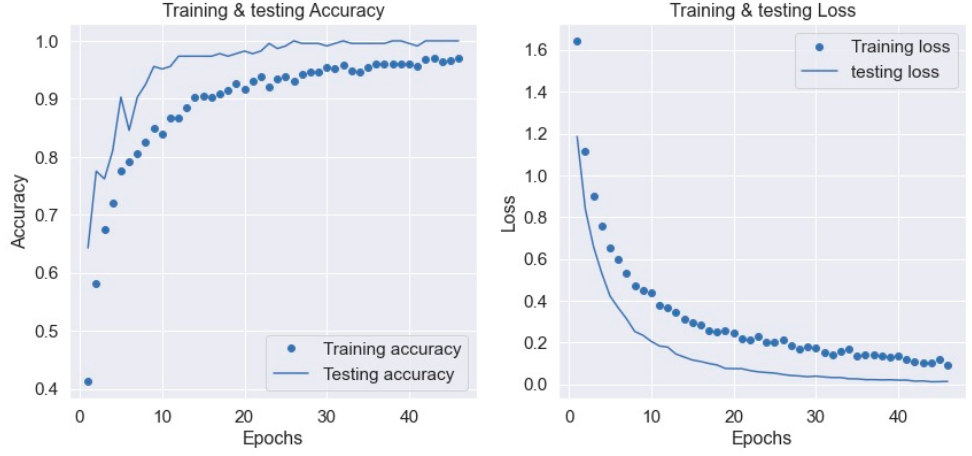
Figure 13. Accuracy and loss of Y_PN-MSSD model when tested in real time.